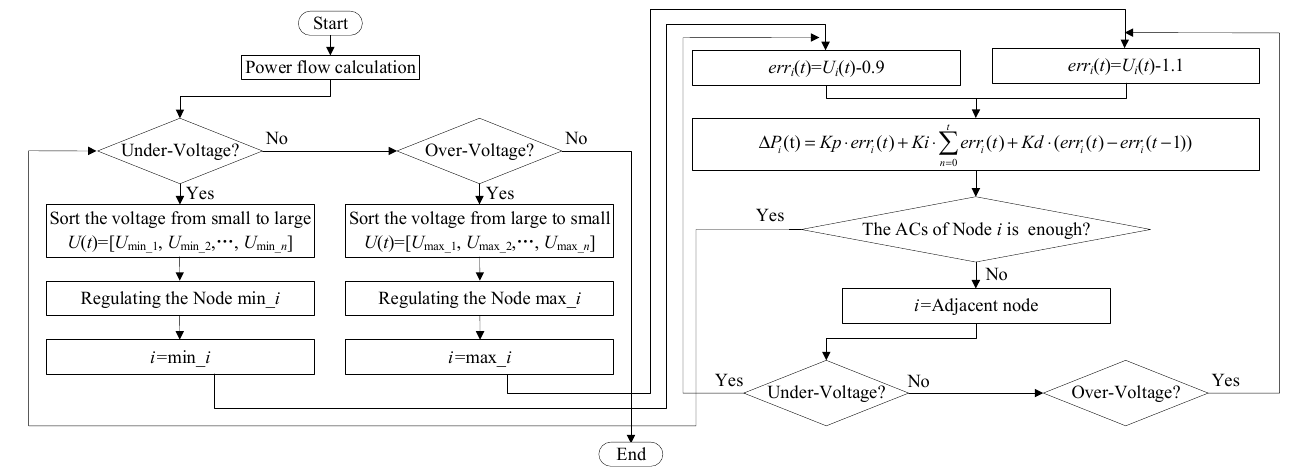
Figure 6. The flow chart of the successive voltage regulation algorithm.